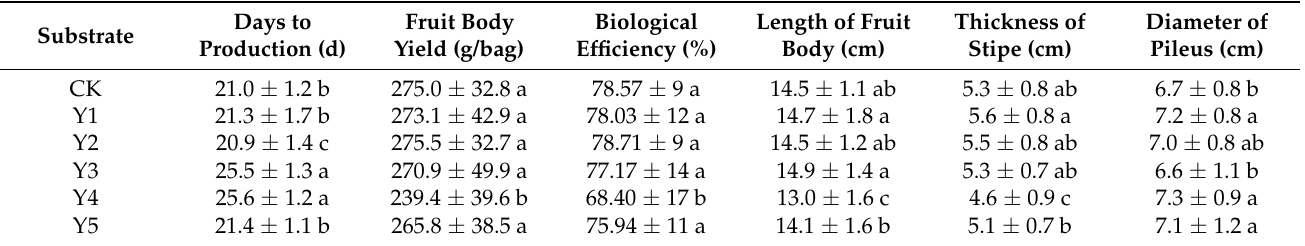
Table 4. Productivity parameters of Pleurotus eryngii when cultivated on different substrates # (mean ± SD, n =